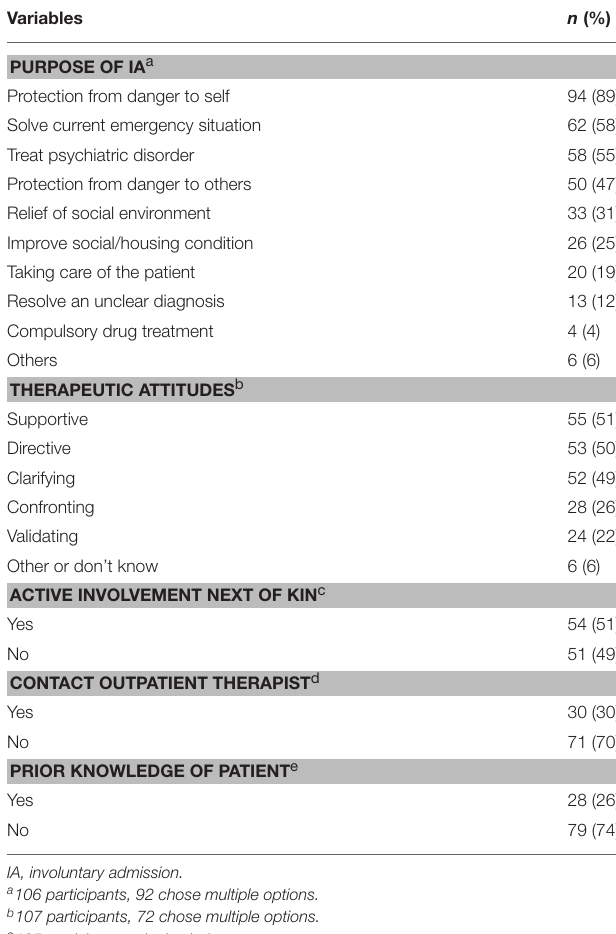
TABLE 3 | Features of the decision-making